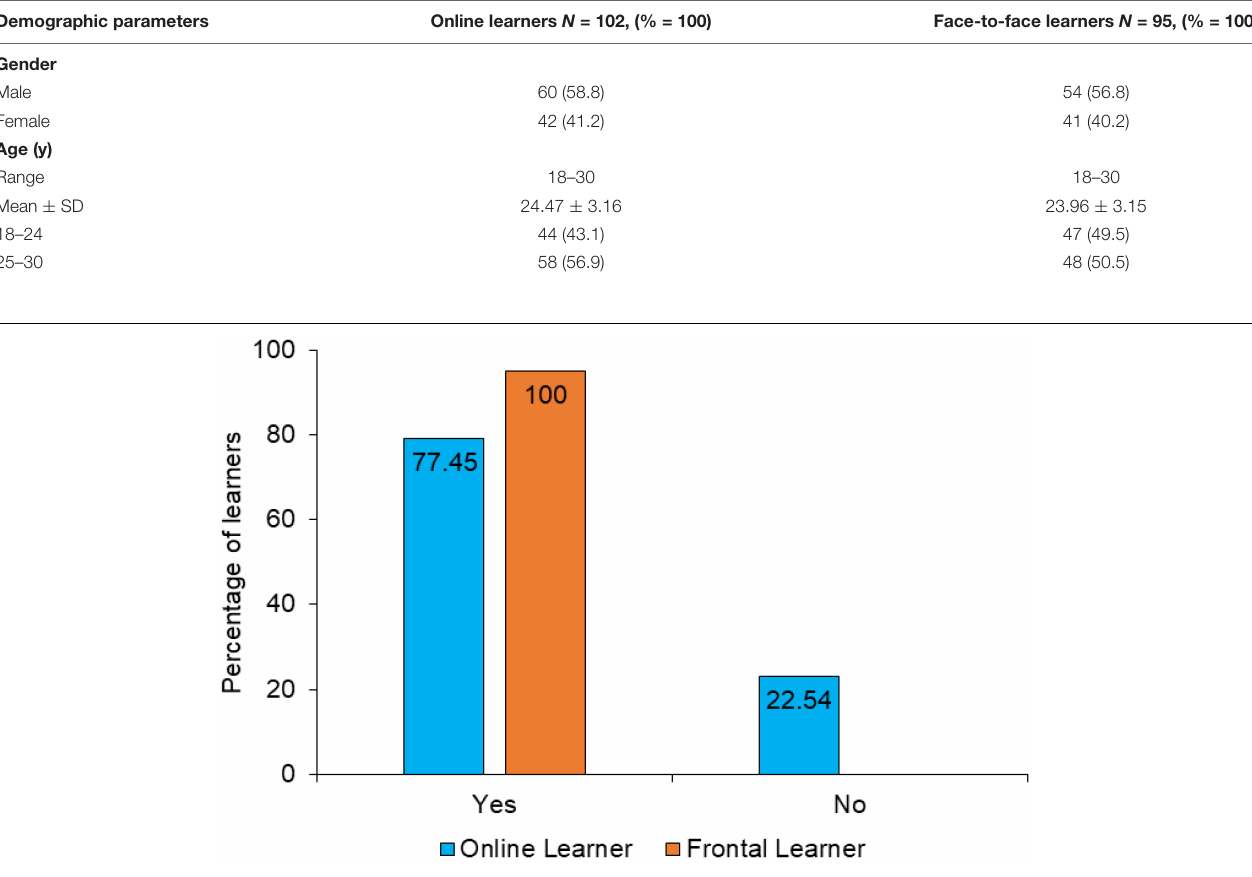
TABLE 1 | Demographic parameters.